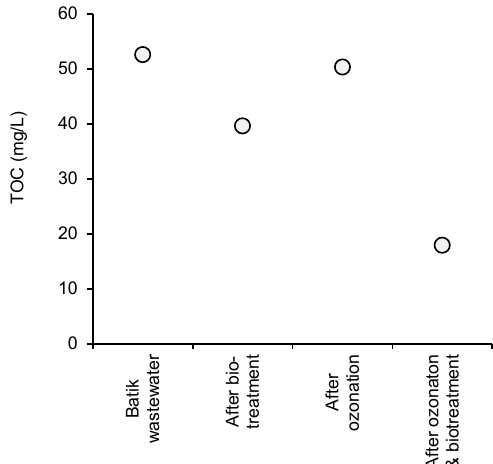
Figure 10. Decrease in TOC concentration in synthetic batik wastewater containing 96 mg/L RB5 and 96 mg/L RO16 after 14 days of biodegradation, 30 min ozonation, and 30 min ozonation followed by 14 days of biodegradation. Figure 11 shows the 3D EEM spectra of the high-strength synthetic batik wastewater. The peaks of RO16 at Ex/Em = 240/425–450 and Ex/Em = 230/350 were predominant (Fig- ure 11A). These peaks decreased after 30 min ozonation (Figure 11B). After 30 min ozona- tion followed by 14 days of biodegradation, a small peak at Ex/Em = 280/370 remained in the treated wastewater (Figure 11C). Figure 11. 3D EEM spectra for high-strength synthetic batik wastewater containing 96 mg/L RB5 and 96 mg/L RO16 treated by ozonation for 0 min ( A ) and 30 min ( B ); and ozonation for 30 min followed by biodegradation for 14 days ( C ). All samples were 10-fold diluted for analysis. 4. Discussion Synthetic batik wastewater typically containing 16–2000 mg/L of dyes (Table 1), sil- ica, wax, and resin has been used to study alternative treatment systems [3–5]. Rashidi et al. [3] studied the use of a baffle separation tank for removing wax from synthetic wastewater (reactive dye 16 mg/L, sodium silicate 1 g/L, and wax 7.7 g/L). Although 92– 95% of the wax and 32–42% of the silicate were removed, only 2–5% of the reactive dyes were removed by baffle separation [3]. Therefore, this study specifically examined the re- moval of azo dyes (48–96 mg/L) from batik wastewater. Ozone and hydroxyl radicals under alkaline conditions are highly reactive with the azo double bond ( - N=N - ). The ozonation process for RB5 and RO16 in individual solu- tions has previously been studied, as shown in Table 1. This study demonstrated the de- colorization of RB5 and RO16 in a mixture at pH 12 (Figures 2 and 8), suggesting the